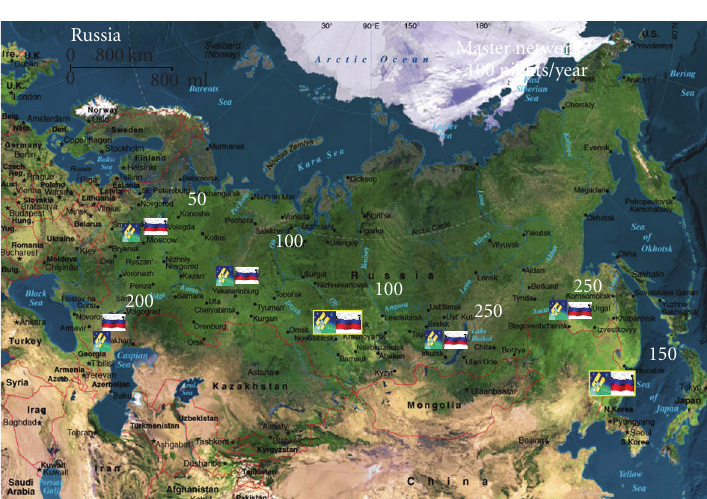
Figure 6: Russian robotic network MASTER. The flags indicate the Russian contribution into gamma-ray burst’s astrophysic. The yellow rectangles indicate planned sites of network stations and the indicators without rectangles introduce already equipped ones. From West to East: Moscow (MASTER I), Kislovodsk (MASTER II, MASTER VWF-4), Ekaterinburg (MASTER II), Novosibirsk (planed), Irkutsk (MASTER II in Tunka (made in November 2009) and VWF-2), Blagoveshchensk (MASTER-I, made in October 2009), and Ussuriysk (planned). The average annual number of clear nights is indicated near each